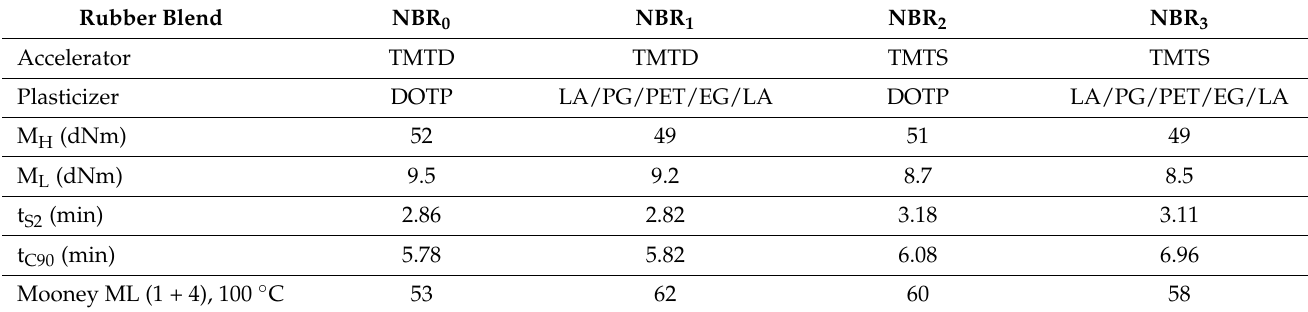
Table 8. The rheological properties of NBR after vulcanization at 150 ◦ C for 15 min.